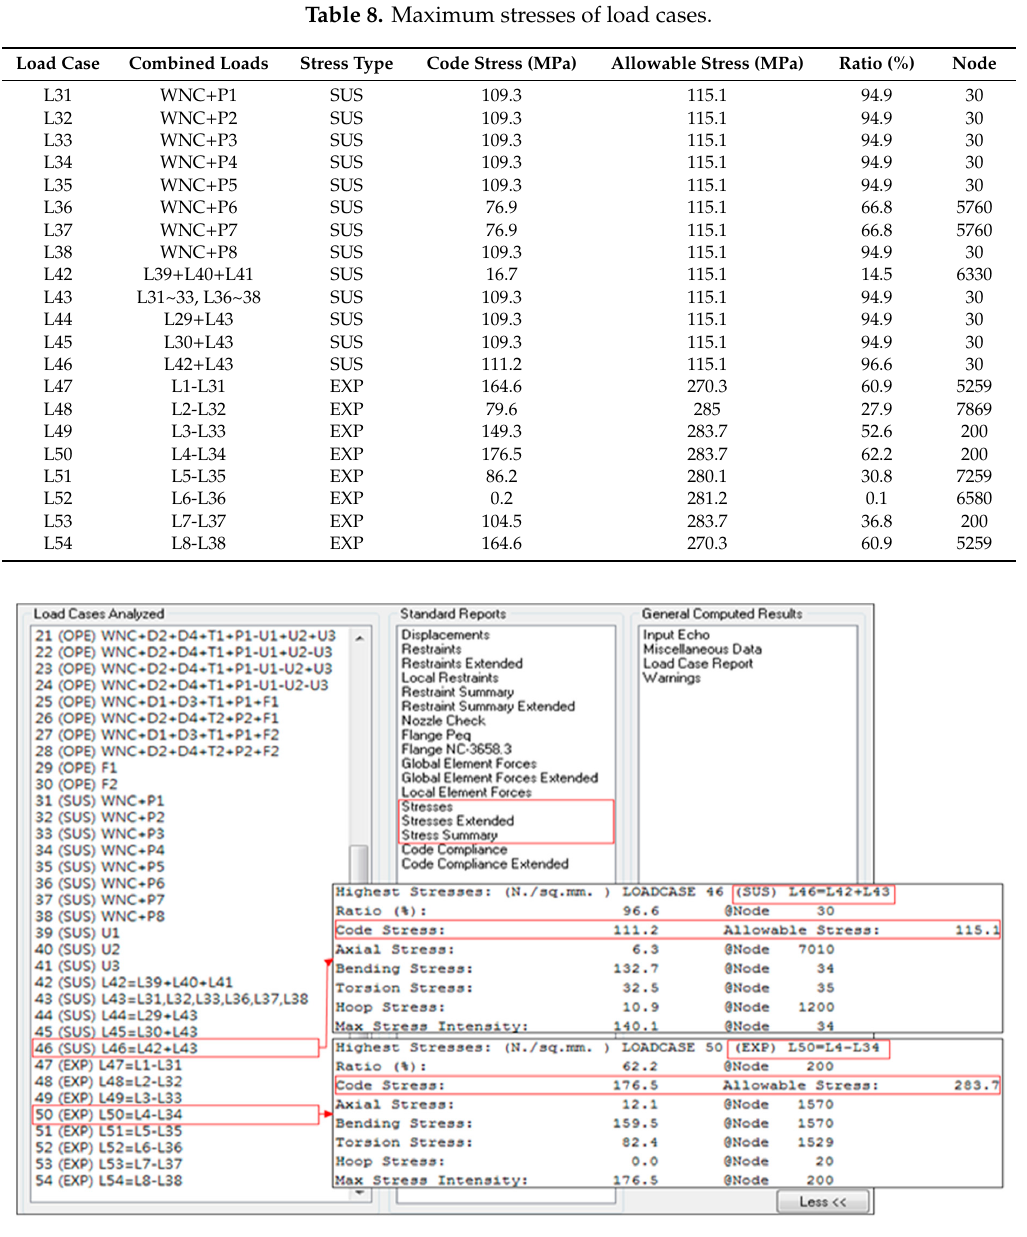
Figure 9. Maximum stress of LNG pipeline of L46 and L50.